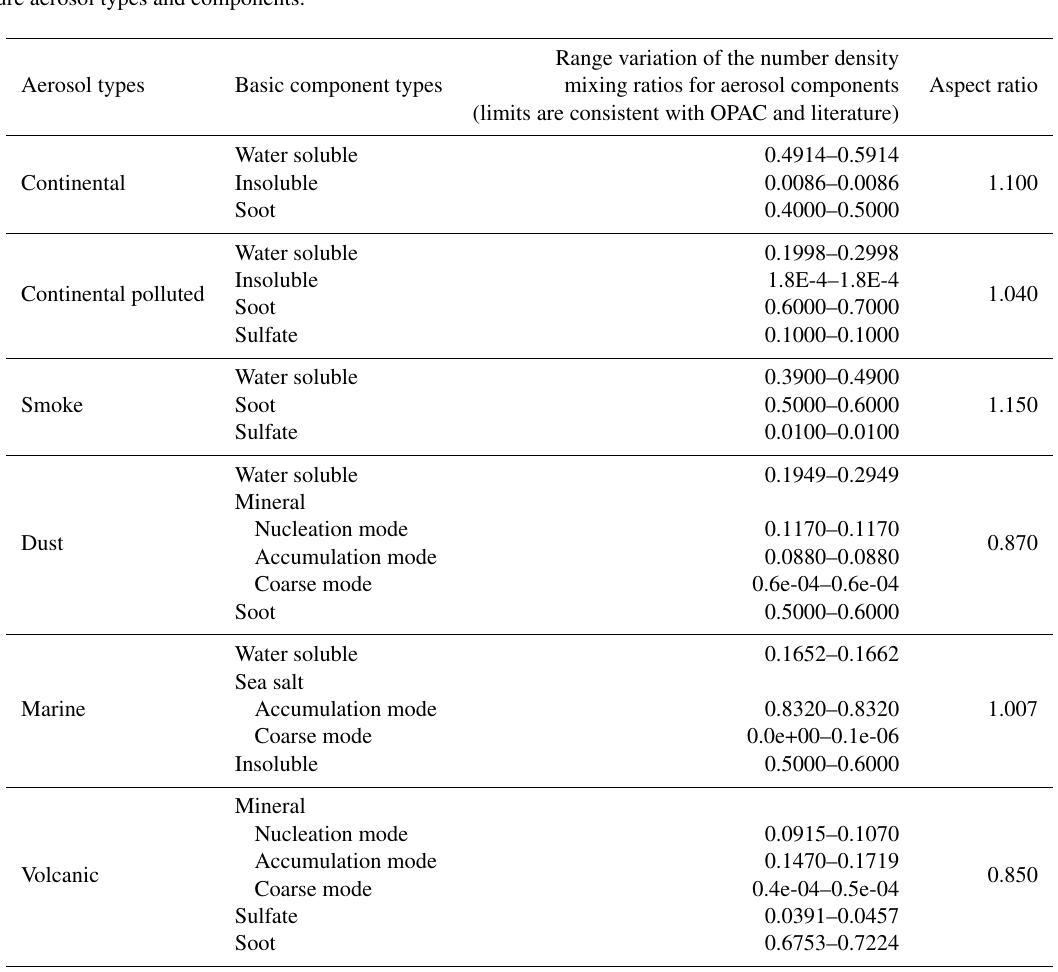
Table 2. Pure aerosol types and